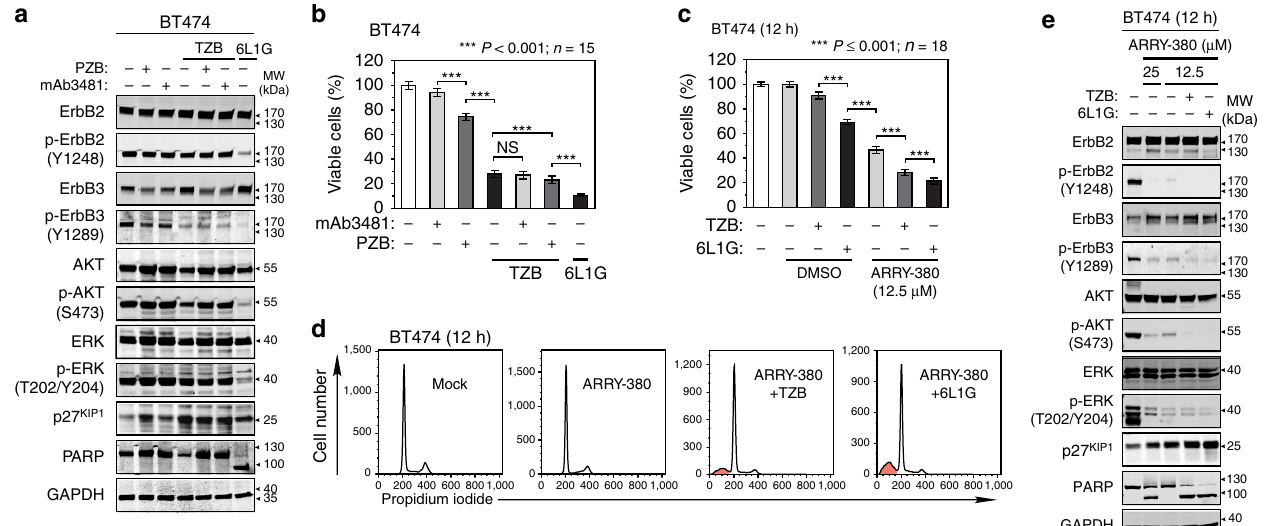
Figure 6 | Blockade of ErbB3 receptor is not sufficient to induce apoptosis without inhibition of ErbB2. ( a , b ) ErbB2-overexpressing cells do not utilize ligand stimulation for reactivation of AKT after inhibition of ErbB3 phosphorylation. BT474 cells were treated for 72h with 100nM 6L1G, PZB and anti-ErbB3 antibody mAb3481, combined with TZB or alone. The status of ErbB2 and ErbB3 receptors and the downstream effectors was determined by immunoblot analysis ( a ), and effects of the treatments on proliferation were estimated by XTTassays ( b ) (Supplementary Fig. 4A,B) (two-sided, unpaired Welch’s t -test). ( c – e ) Combination of ErbB2 and ErbB3 blockade is required to prevent p-AKT rebound and induce cell death. Inhibition of XTT cell proliferation ( c ), cell cycle ( d ) and receptor signalling ( e ) after 12h of treatment with the ErbB2-selective kinase inhibitor ARRY-380 alone or in combination with 100nM TZB or 6L1G (two-sided, unpaired Student’s t